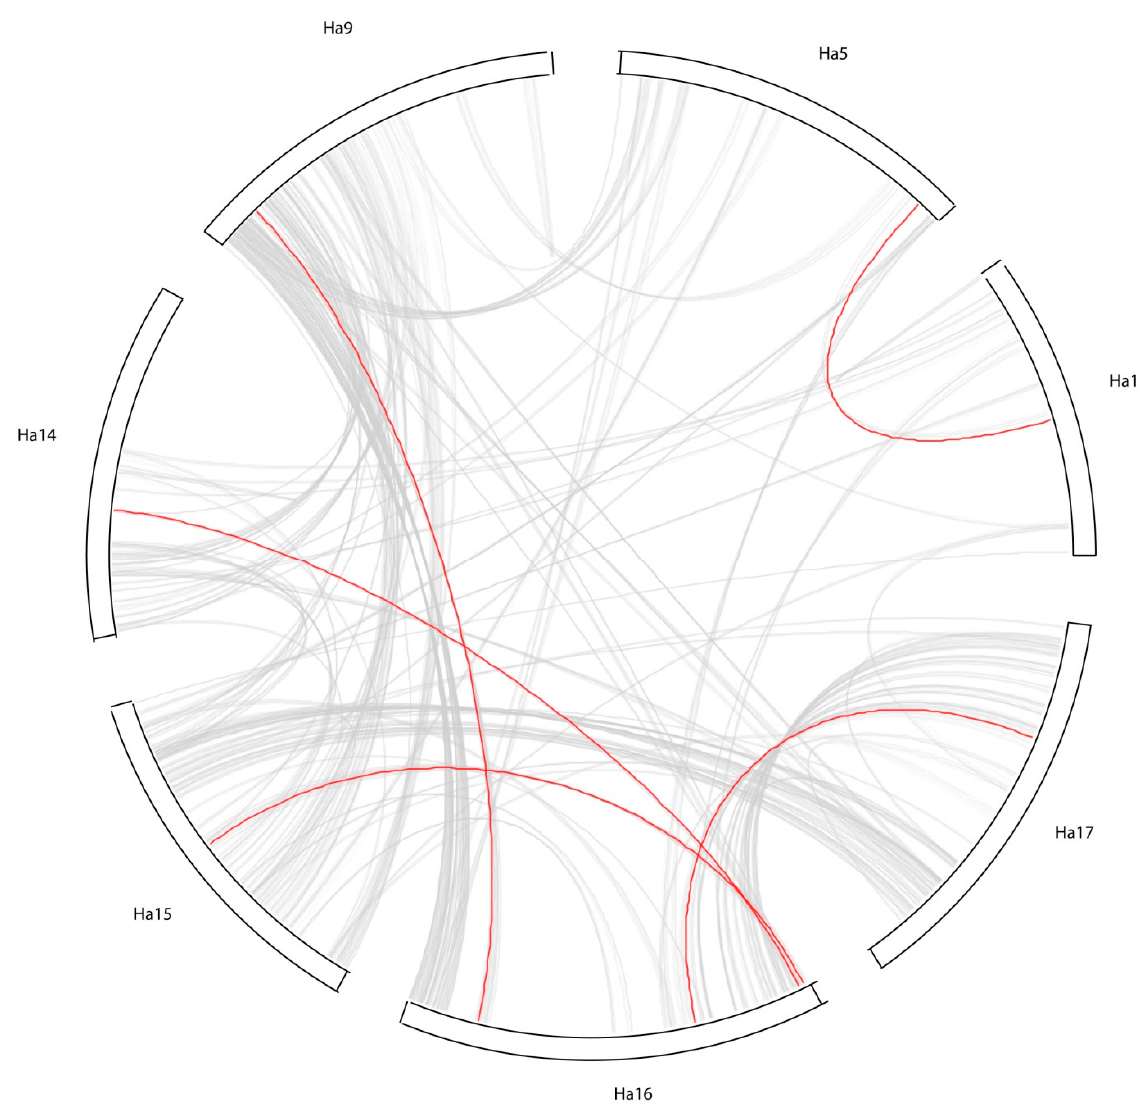
Figure 6. Graphical representation of synteny blocks of Helianthus annuus chromosomes containing HaWOX genes originated in whole genome duplication events. Red arches join a two-synteny block containing WOX originated by whole genome duplication events. Grey arches show synteny blocks for analyzed chromosomes.